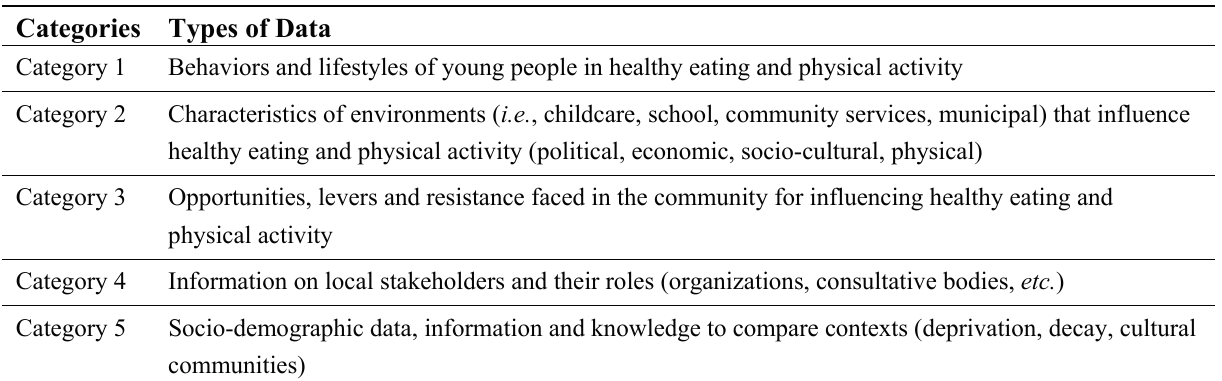
Table 5. The categories of data and information that QEF encourages community networks to